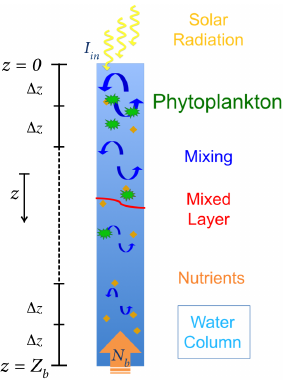
Figure 4. Schematic representation of the processes and the setup of the